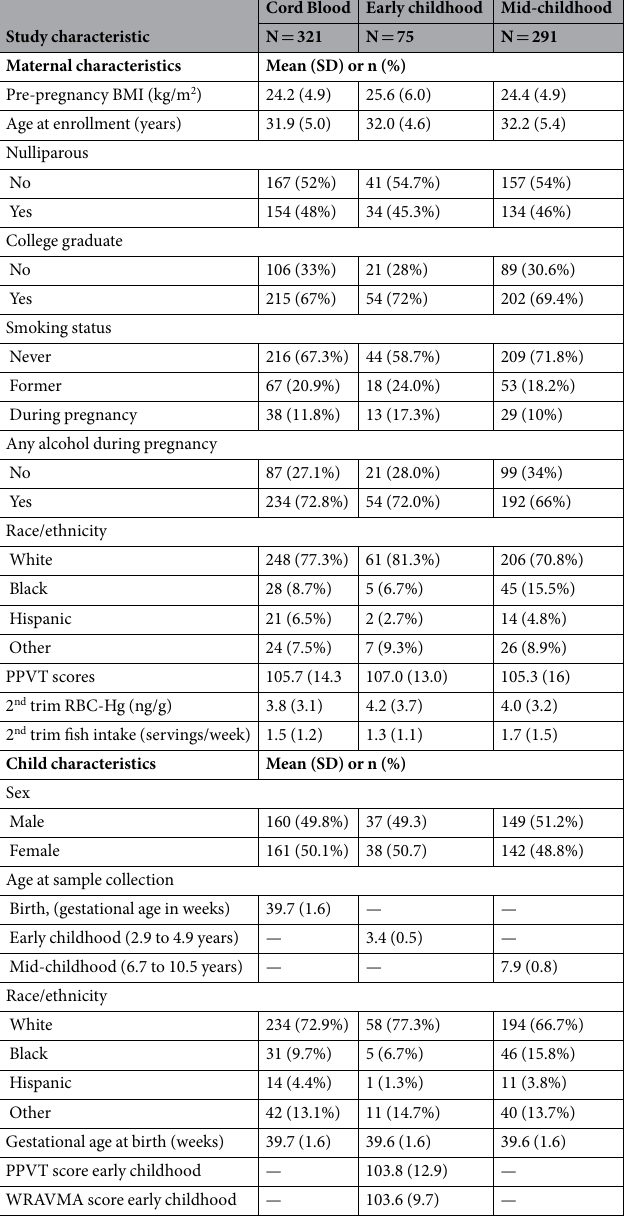
— Table 1. Characteristics of mothers and children in the Project Viva eligible for analysis at birth (cord blood) and during early (2.9–4.9 years) and mid-childhood (6.7–10.5